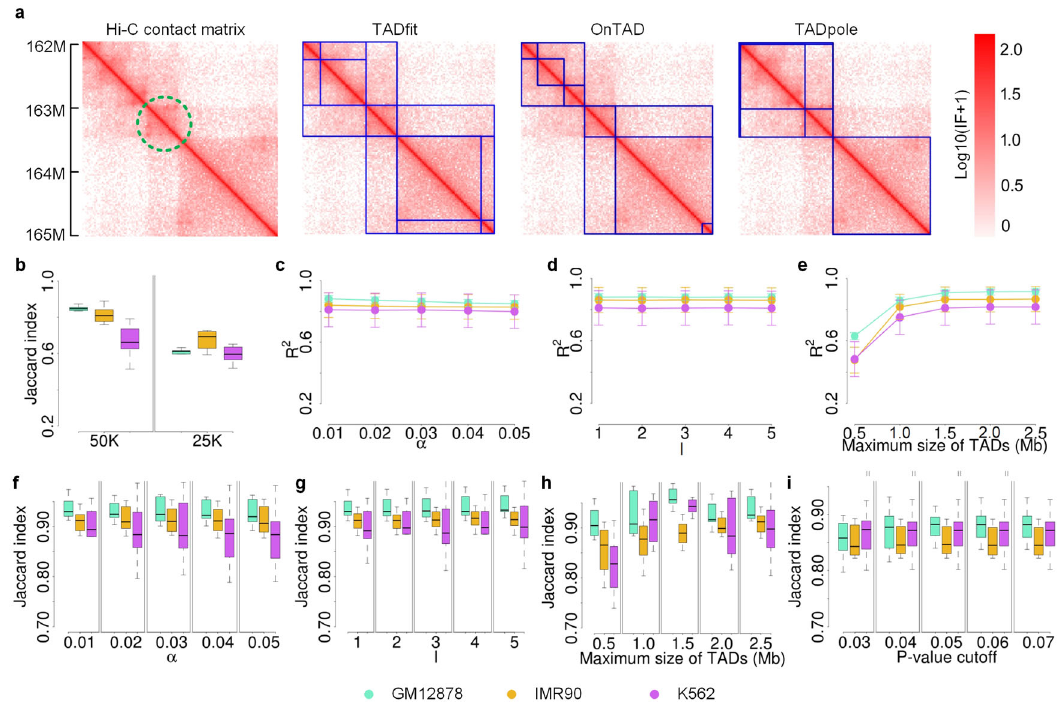
Fig. 5 Illustration of TAD fi t in handling partially overlapping TADs and the robustness to hyperparameters. To analyze the ability of TAD fi t in handling partially overlapping TADs, the hierarchical TADs were called by TAD fi t on contact matrix replicates (GSM1551550_HIC001 – GSM1551554_HIC005) for chromosome 1 of GM12878 at 25K resolution, and one of the replicates (GSM1551550_HIC001) was fed into OnTAD and TADpole, since they cannot accept multiple replicates as input. a Heatmaps of contact matrix (GSM1551550_HIC001, 162 Mb – 165 Mb) and the hierarchical TADs called by the three methods on it were drawn. There are four heatmaps shown above, on the fi rst of which a partially overlapping TAD was marked with a green dotted circle, and on the last three of which the called TADs were outlined with blue solid line. Besides, to investigate the reproducibility of partially overlapping TADs called by TAD fi t, the contact matrix replicates for chromosome 1 of three cell lines (GM12878, IMR90, and K562) at resolutions of 50K and 25K were fed into TAD fi t individually, and b the Jaccard index of partially overlapping TADs across replicates were shown. In addition, to analyze the affection of the tuning of two hyperparameters ( α for per-coordinate learning rate and l for the strength of L 1 regularization) on the iterative optimization, as well as the tuning of two parameters (the maximum size of TADs and p -value cutoff of permutation test) on the identi fi cation of hierarchical TADs, the contact matrix replicates for chromosome 1 of three cell lines (GM12878, IMR90, and K562) at 25K resolution were separately fed into TAD fi t with each cell line as a group. c – e The curves of R 2 (mean ± SD) with different α , l and maximum sizes of TADs, as well as f – i the Jaccard index of called TADs across replicates with different α , l , maximum sizes of TADs and p -value cutoffs were given, respectively. The center line of the box indicates the median, whereas the bottom and top of the box indicate the fi rst and third quartiles, respectively, and whiskers are extended to the most extreme data point that is no more than 1.5 × interquartile range from the bottom and top of the